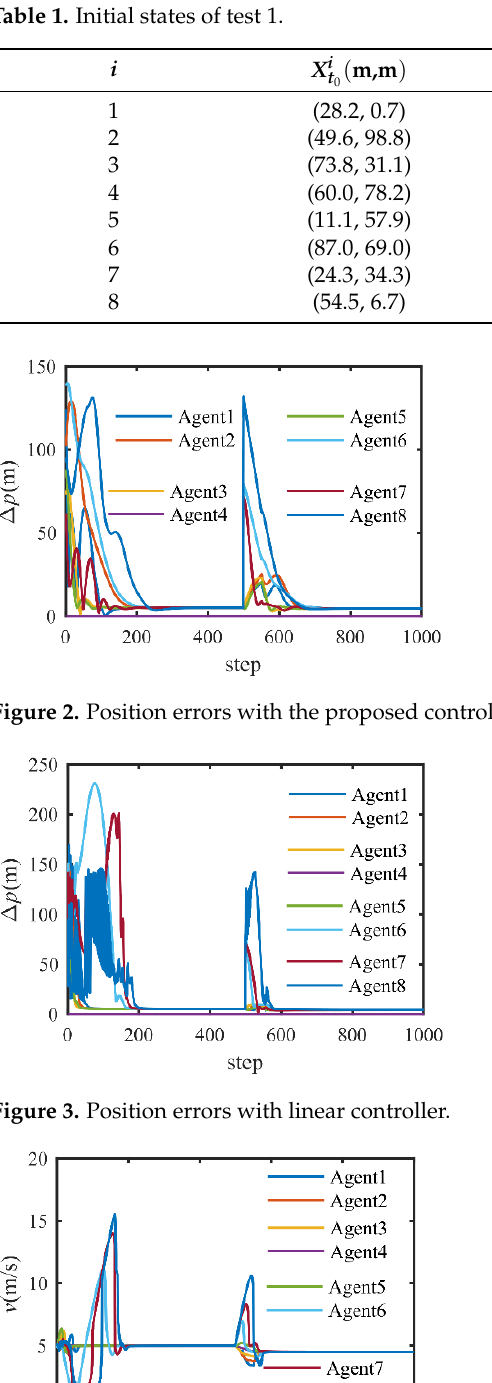
Figure 5. Angular rate control result with linear controller.